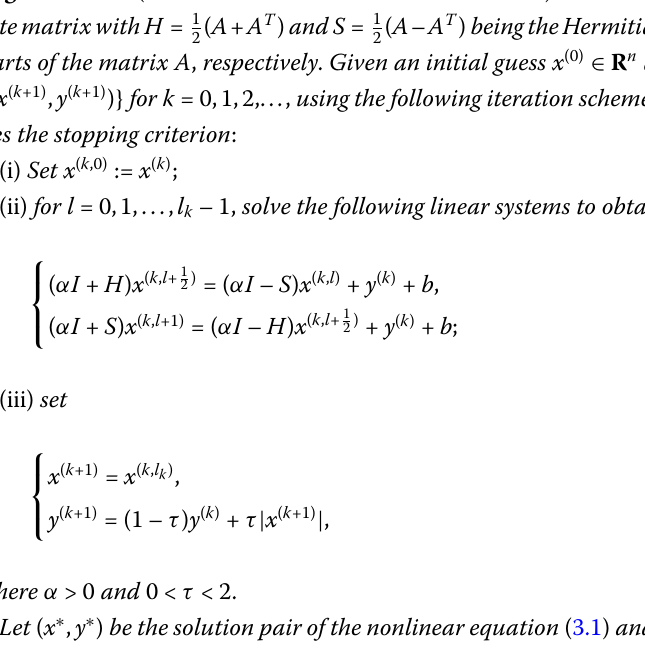
Algorithm 3.1 (The Picard-HSS-SOR iteration method) Let A ∈ R n × n be a positive defi- nite matrix with H = 1 ( A + A T ) and S = 1 ( A – A T ) being the Hermitian and skew-Hermitian 2 2 parts of the matrix A , respectively . Given an initial guess x (0) ∈ R n and y (0) ∈ R n . Compute { ( x ( k +1) , y ( k +1) ) } for k = 0,1,2,..., using the following iteration scheme until { ( x ( k ) , y ( k ) ) }